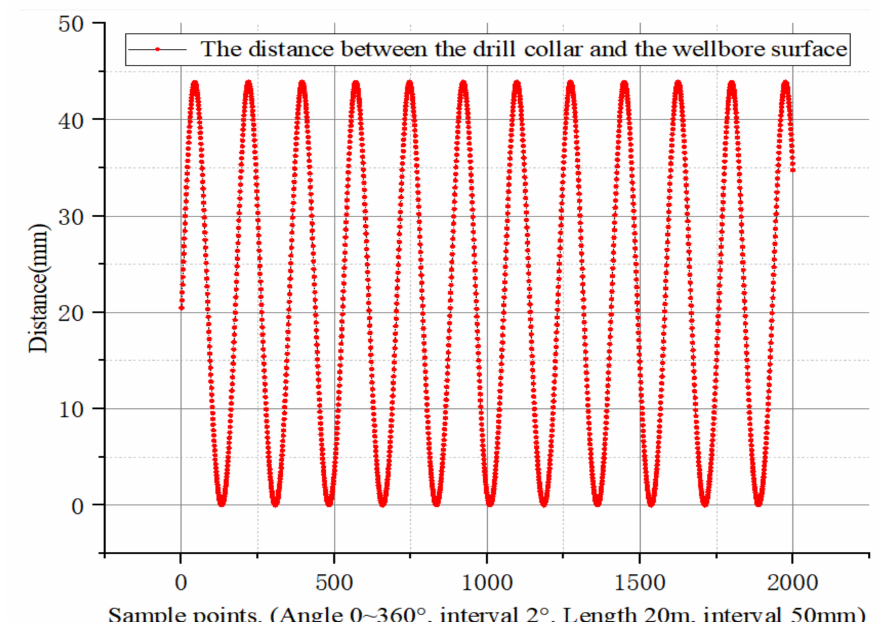
Figure 10. Eccentricity distance in order of recorded